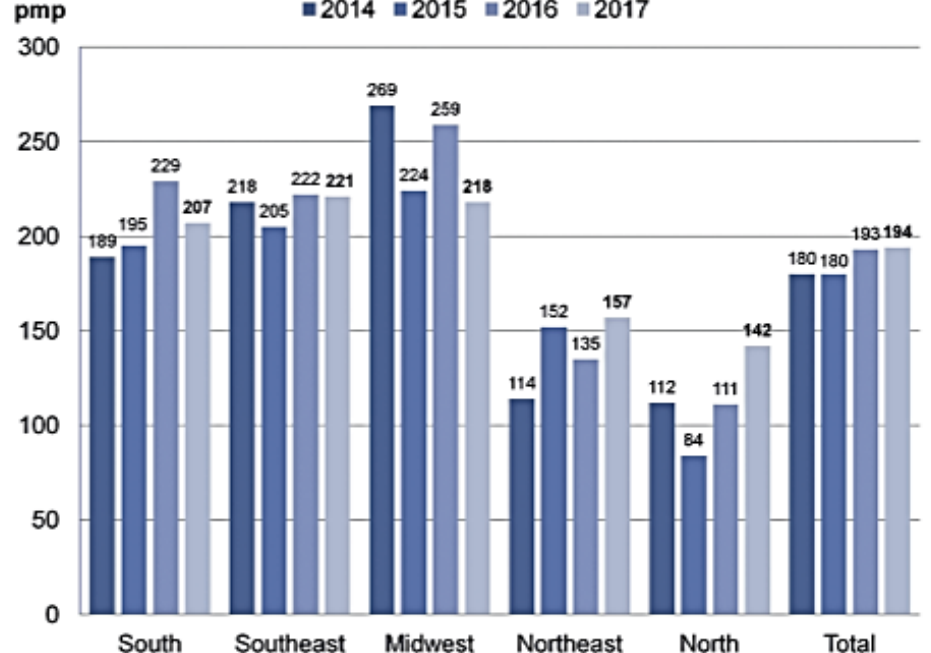
FIGURE 2 - Estimated incidence of dialysis patients in Brazil, by region in the period of 2014-2017 (SOURCE: Adapted from Thomé et al. ,